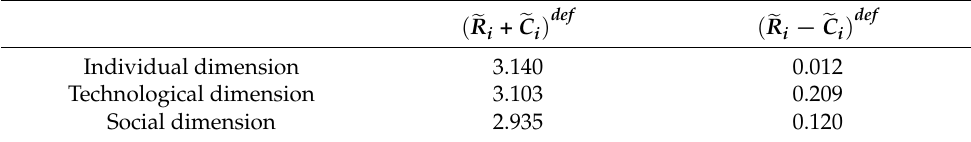
def def and ( (cid:101) R i − (cid:101) C i ) impacts using three measurements.